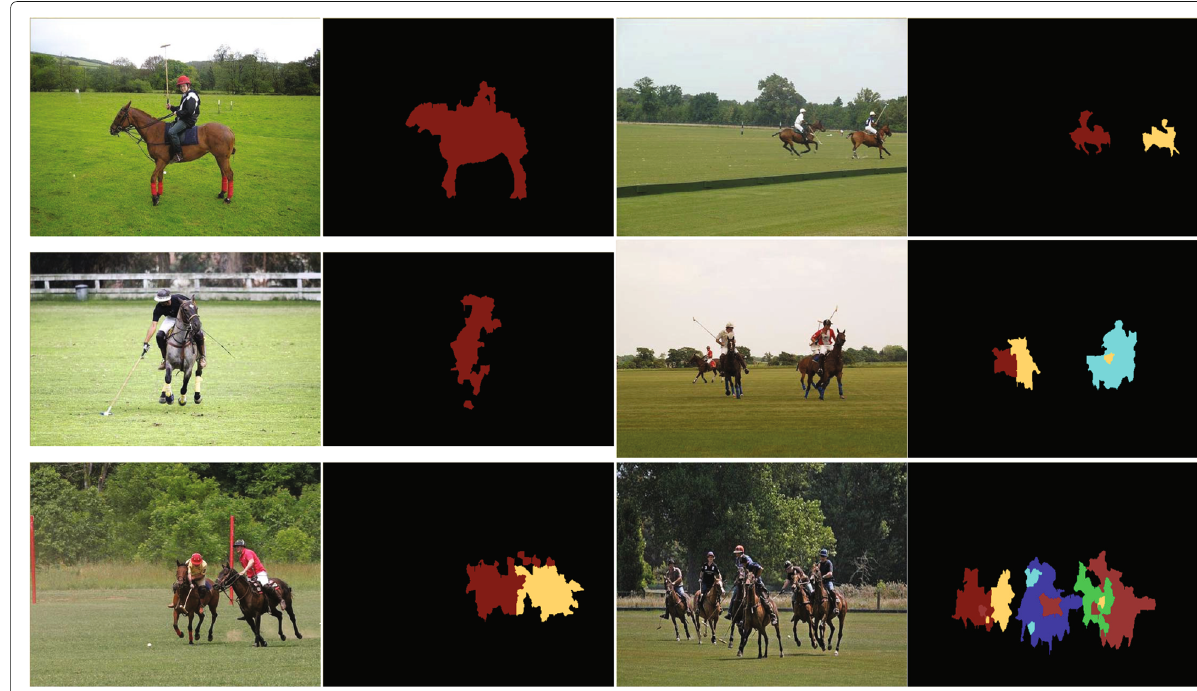
Fig. 9 Examples of object labeling result on Polo dataset. Different colors indicate different instances. Other categories are visualized as void